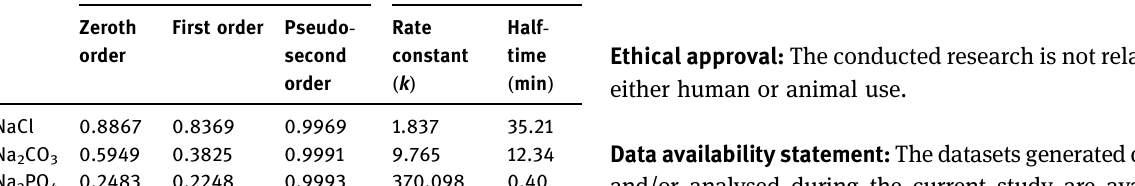
Table 2: Linear correlation coe ffi cient, rate constant, and half - time for pseudo - second order of CaAl - MCPA Linear correlation coe ffi cient ( R 2 ) Pseudo - second